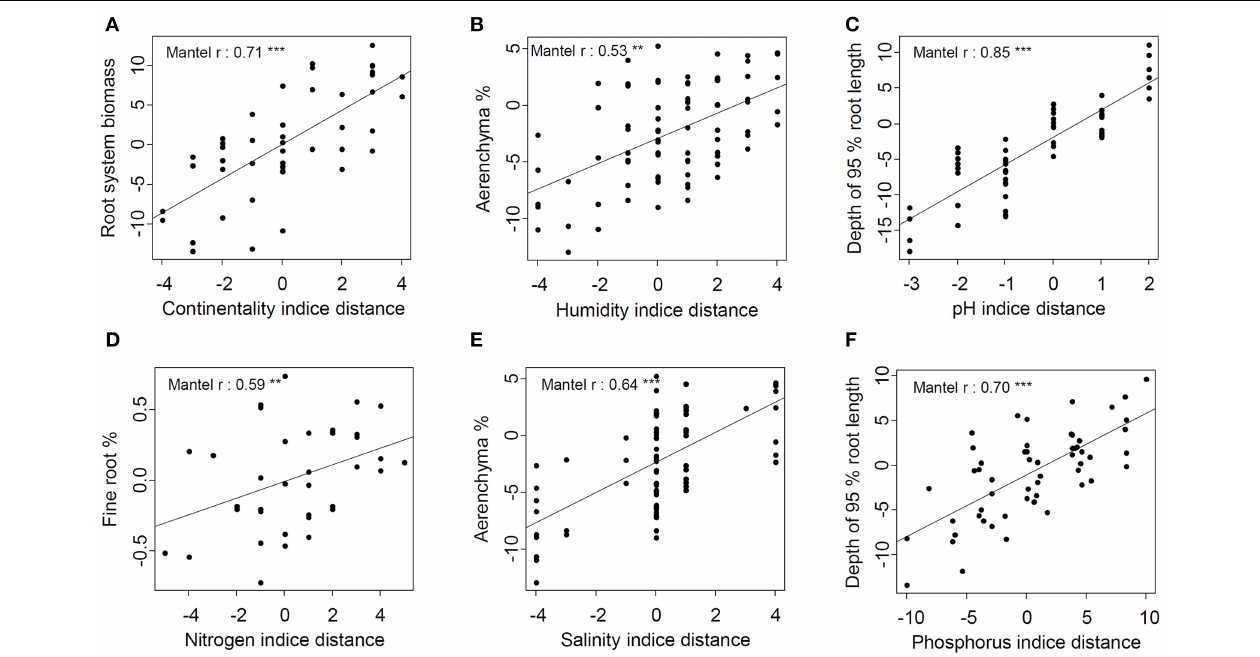
FIGURE 5 | Best relations between hierarchical trait distance and each ecological indicator’s hierarchical distance. (A) Root system biomass and continentality indicator; (B) Aerenchyma % and humidity indicator; (C) Depth of 95 % root length and pH indicator; (D) Fine root % and nitrogen